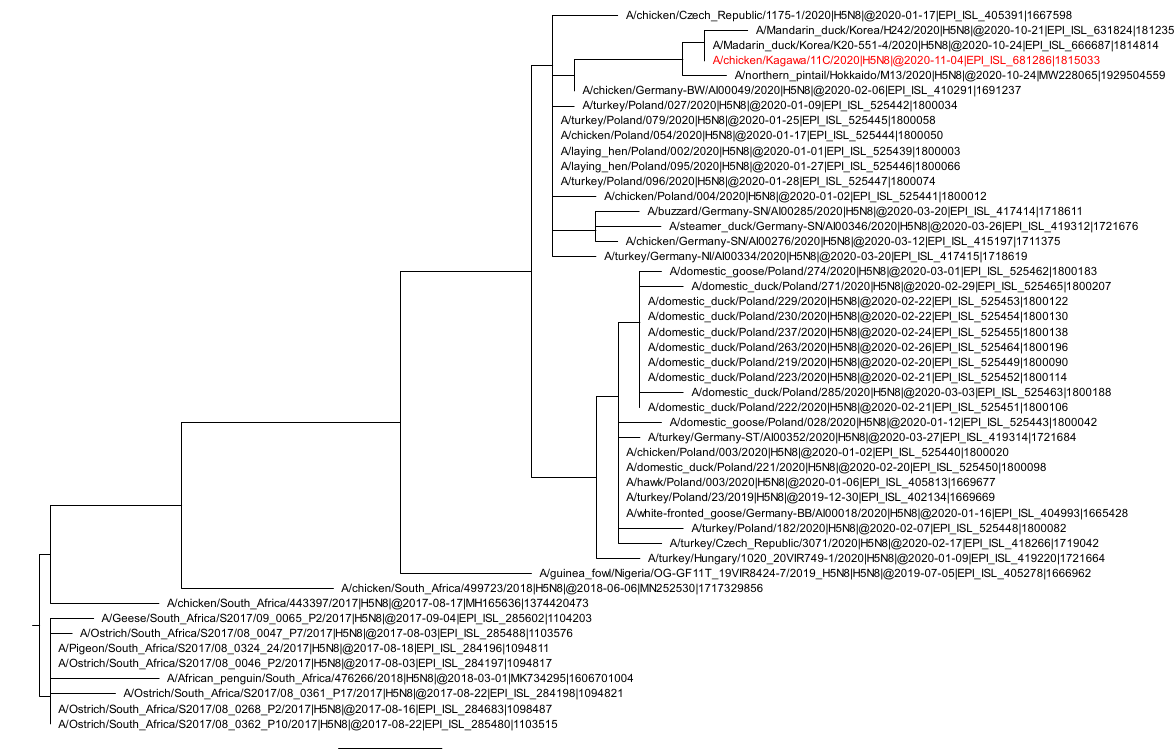
Figure 1. Expansion of clade 2.3.4.4B in phylogenetic tree of H5 subtype HA gene. Chickens were inoculated intranasally with Kagawa11C2020 to estimate the 50% chicken lethal dose (CLD 50 ) and mean time to death (MTD). All of the chickens inoculated with 10 6 EID 50 and four of the five chickens inoculated with 10 5 EID 50 died, whereas all of the chickens inoculated with the 10 2 or 10 4 EID 50 dose survived. All chickens that died from infection showed depression beginning on 3 dpi at the earliest (one chicken), but comb cyanosis occurred in only one chicken in each of the 10 5 and10 6 EID 50 groups. The MTD of chickens inoculated with 10 6 EID 50 was 134.4 h, and the CLD 50 of Kagawa11C2020 was 10 4.63 (Table). None of the chickens that survived in 10 2 , 10 4 and 10 5 EID 50 inoculation groups was ELISA-positive for antibody against type A influenza virus; they had there- fore not been infected with the virus. By comparing the survival of chickens, inoculated with 10 6 EID 50 of H5 HPAIVs iso- lated previously in Japan during 2004 through 2018 [5,11,18,21,22], showed that the sur- vivability of Kagawa11C2020 was significantly higher than those of the other Japanese isolates except for A/chicken/Miyazaki/7/2014 (Miyazaki2014, H5N8), A/duck/Chiba/26- 372-48/2014 (Chiba2014, H5N8) and A/Muscovy duck/Aomori/1-3T/2016 (Aomori2016, H5N6) (Table 1). Furthermore, the MTD was significantly longer in chickens infected with Kagawa11C2020 than in those infected with previous viruses except Miyazaki2014 (Table 1).